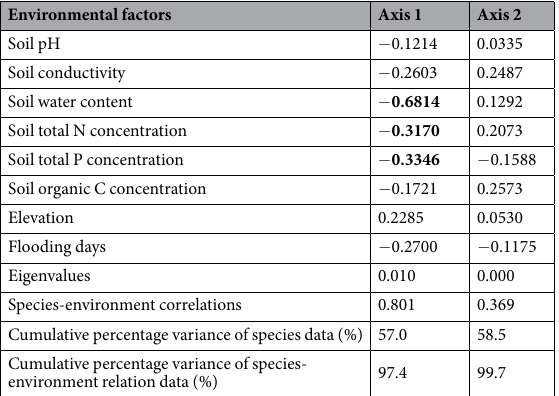
Table 3. Summary of Canonical Correspondence Analysis (CCA) ordinations.